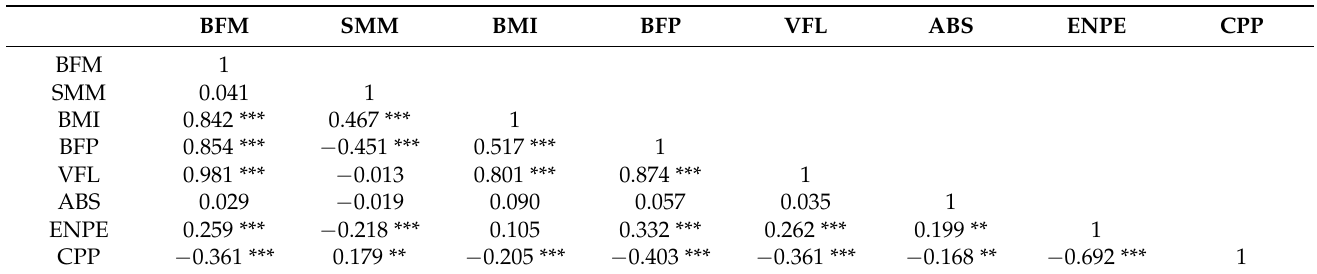
Table 2. Correlation matrix between mean scores of the constructs evaluated by the Attention to Body Shape Scale and Social Physique Anxiety Scale with the components of body